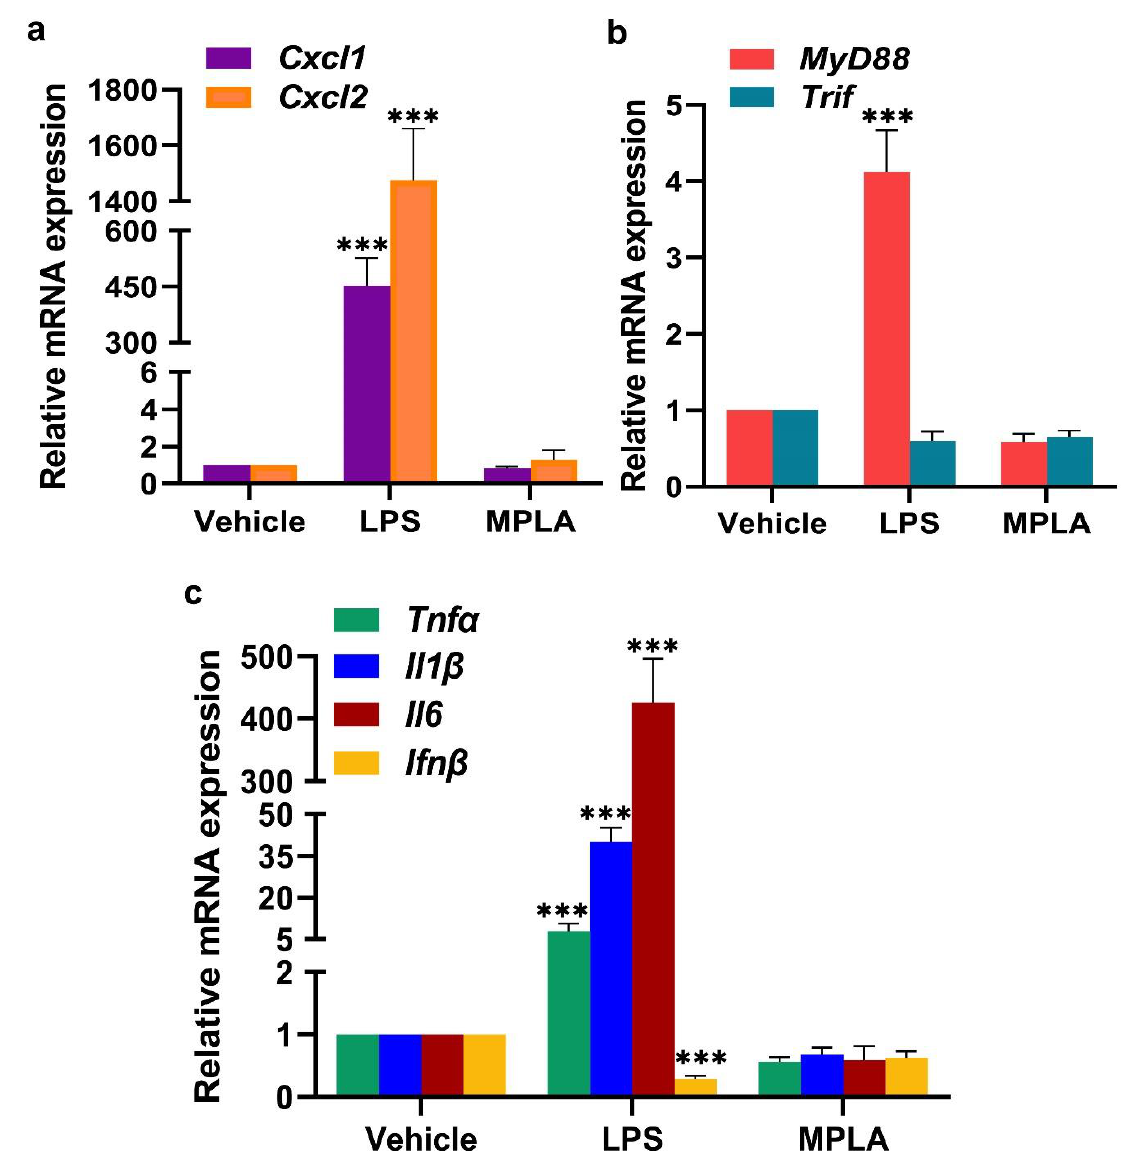
Figure 7. Maternal LPS exposure elevated expression of mRNAs of chemokines and MyD88 and MyD88-modulated cytokines, but not Trif and Trif-modulated cytokine at the EBISs. Expressions of mRNAs of chemokines, Cxcl1 and Cxcl2 ( a ), adaptor proteins, MyD88 and Trif ( b ) and cytokines, TNFα, Il1β, Il6, and Ifnβ ( c ) were determined by quantitative RT-PCR. All EBISs were collected 2 h after vehicle or MPLA (1 µg) or LPS (1 µg) injection (i.p.). Data were normalized to GAPDH, expressed as Mean ± SD of three experiments and one-way ANOVA followed by Tukey’s test was applied for statistical analysis. *** p ≤ 0.001.